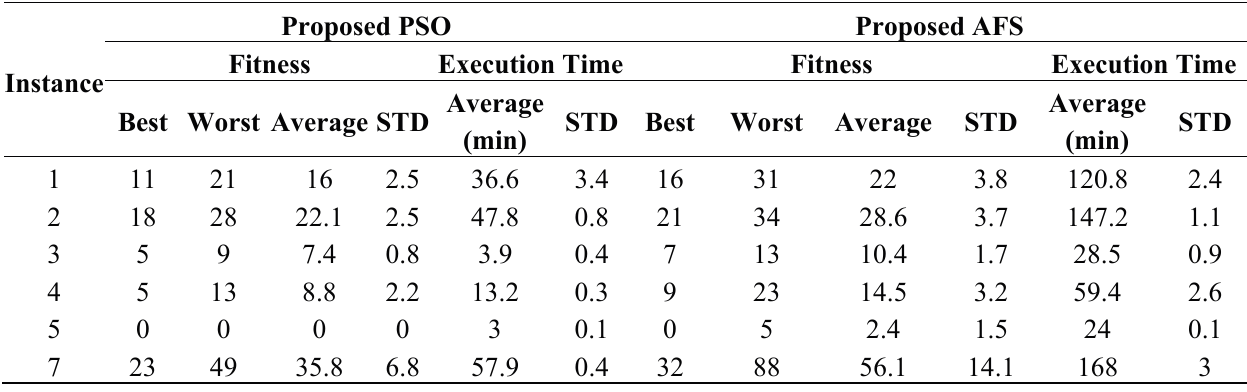
Table 3. Experimental results of the proposed stochastic algorithms.